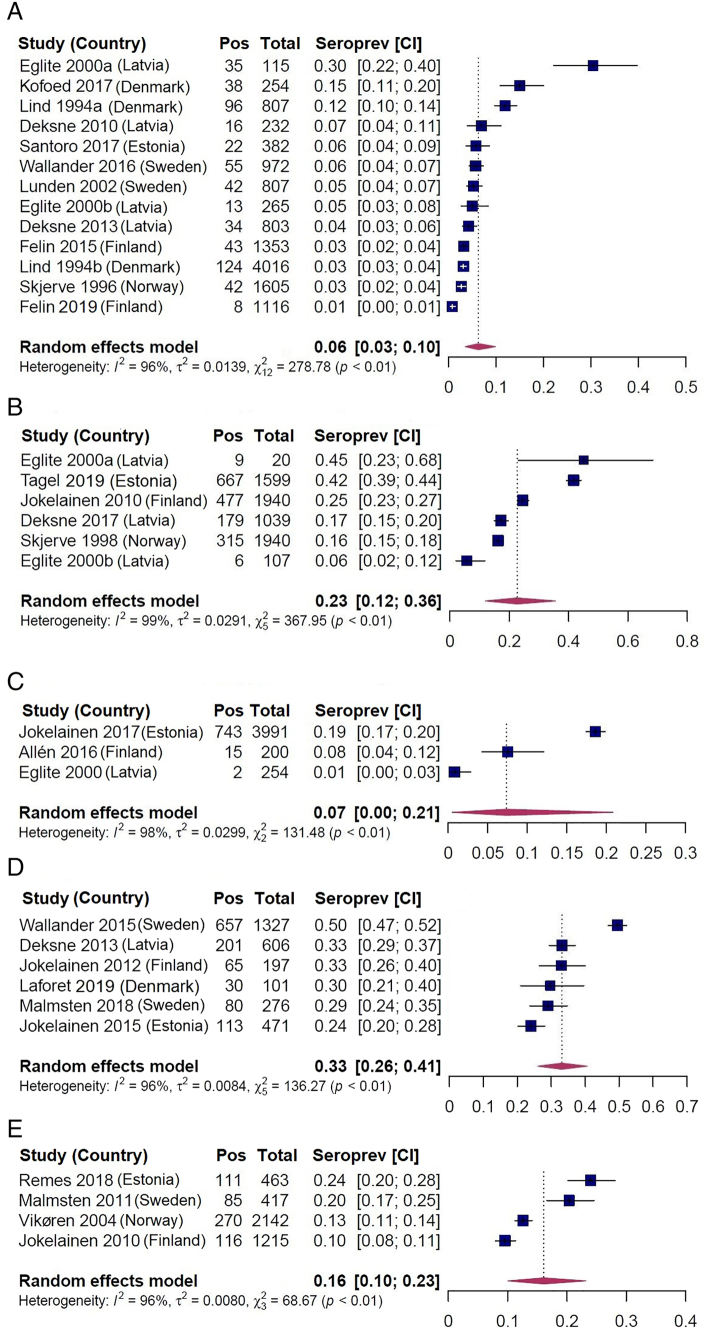
A. Forest plot of Toxoplasma gondii seroprevalence in domestic pigs (Sus scrofa domesticus) in the Nordic-Baltic region estimated with random-effects model ignoring the effect of geography, production system, and age.References: (Lind et al., 1994; Skjerve et al., 1996; Eglīte and Keidans, 2000; Lundén et al., 2002; Deksne, 2010; Deksne and Kirjušina, 2013; Felin et al., 2015; Wallander et al., 2016; Kofoed et al., 2017; Santoro et al., 2017; Felin et al., 2019).B. Forest plot of Toxoplasma gondii seroprevalence in sheep (Ovis aries) in the Nordic-Baltic region with random-effects model ignoring the effect of geography and age.References: (Skjerve et al., 1998; Eglīte and Keidans, 2000; Jokelainen et al., 2010; Deksne et al., 2017; Tagel et al., 2019).C. Forest plot of Toxoplasma gondii seroprevalence in cattle (Bos taurus) in the Nordic-Baltic region with random-effects model ignoring the effect of geography and age.References: (Eglīte and Keidans, 2000; Allén, 2016; Jokelainen et al., 2017).D. Forest plot of Toxoplasma gondii seroprevalence in wild boars (Sus scrofa) in the Nordic-Baltic region with random-effects model ignoring the effect of geography and age.References: (Jokelainen et al., 2012; Deksne and Kirjušina, 2013; Jokelainen et al., 2015; Wallander et al., 2015; Malmsten et al., 2018; Laforet et al., 2019).E. Forest plot of Toxoplasma gondii seroprevalence in moose (Alces alces) in the Nordic-Baltic region with random-effects model ignoring the effect of geography and age.References: (Vikøren et al., 2004; Jokelainen et al., 2010; Malmsten et al., 2011; Remes et al., 2018).Pos = number of animals that tested seropositive.Total = number of animals sampled.Seroprev [CI] = estimated apparent seroprevalence and its 95% confidence interval (CI), presented in descending order.